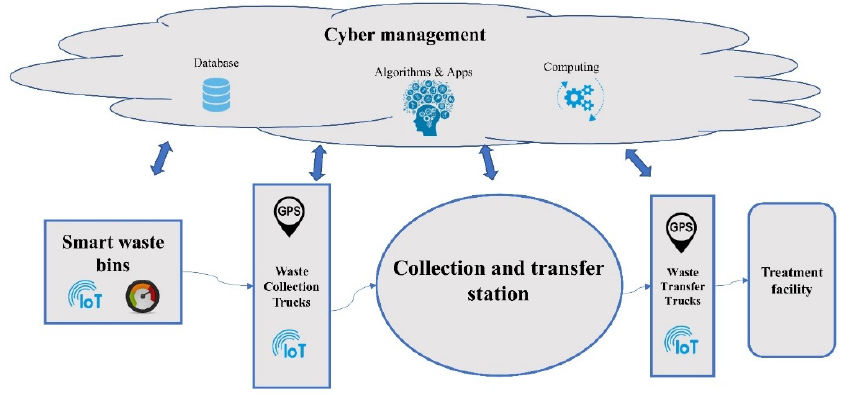
Figure 1. Cyber-physical waste management system scheme.